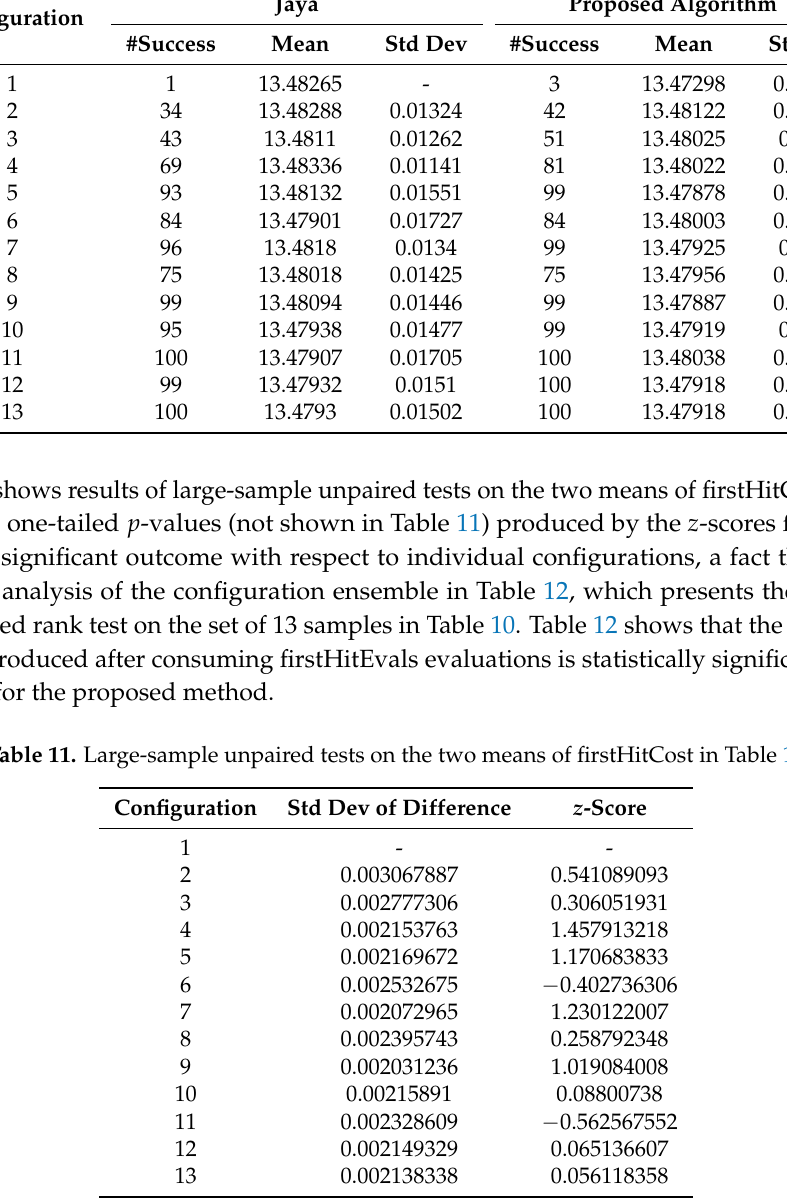
Table 10. Mean and standard deviation of firstHitCost (each row is obtained from the same set of 100 independent runs used in Table 7 for each algorithm). Jaya